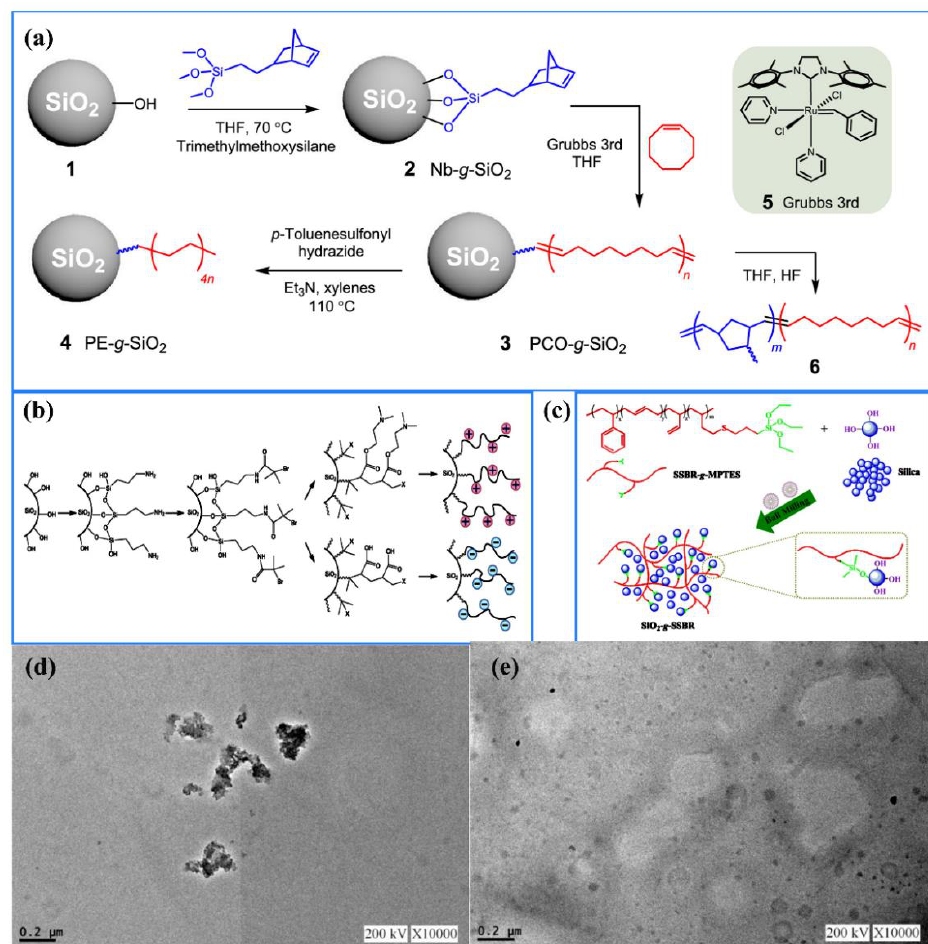
Figure 4. Legend of polymer grafted SNs modification. ( a ) Synthesis flow chart of SNs grafted with poly(cyclooctene) and polyethylene. Adapted with permission from [140]. Copyright 2020, American Chemical Society. ( b ) Schematic diagram of surface modification and polymerization of PDMAEMA or PMAA on SNs. Adapted with permission from [143]. Copyright 2018, American Chemical Society. ( c ) Diagram of SSBR-g-MPTES grafted onto SNs by ball milling. Adapted with permission from [144]. Copyright 2019, American Chemical Society. ( d ) PHB with 5 wt% bare SNs. Adapted with permission from [145]. Copyright 2017, Elsevier. ( e ) PHB with 5 wt% PEG-silica. Adapted with permission from [145]. Copyright 2017, Elsevier.